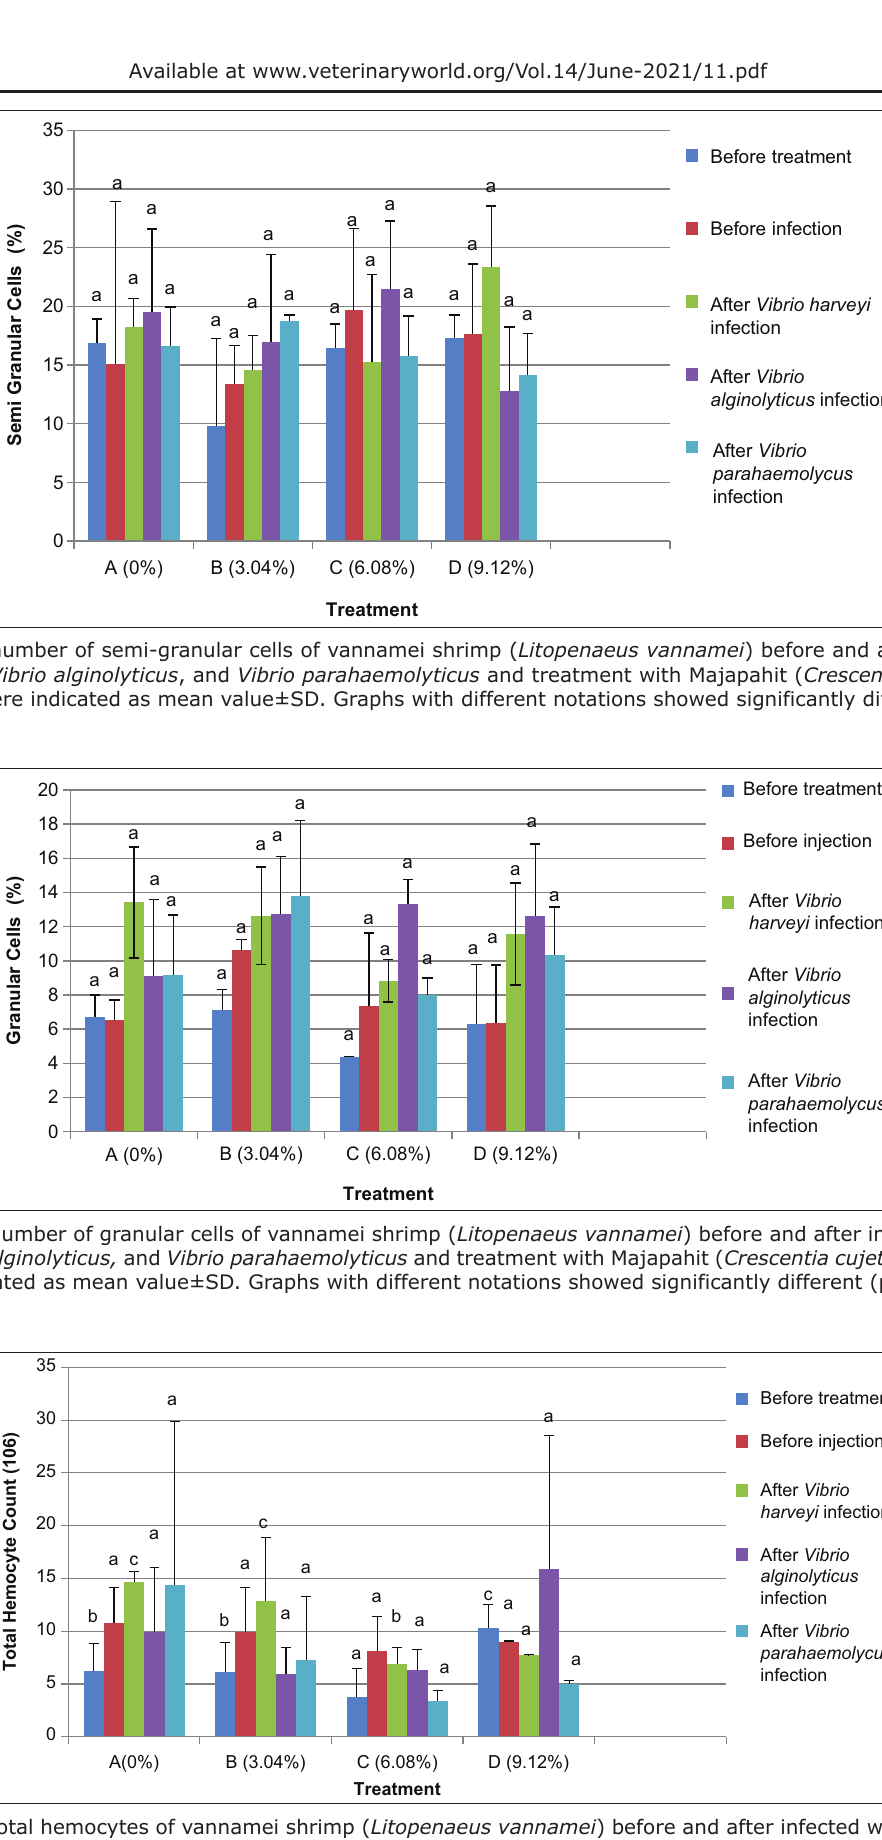
Figure-4: The total hemocytes of vannamei shrimp ( Litopenaeus vannamei ) before and after infected with Vibrio harveyi, Vibrio alginolyticus, and Vibrio parahaemolyticus and treatment with Majapahit ( Crescentia cujete L.) fruit powder. Data were indicated as mean value±SD. Graphs with different notations showed significantly different